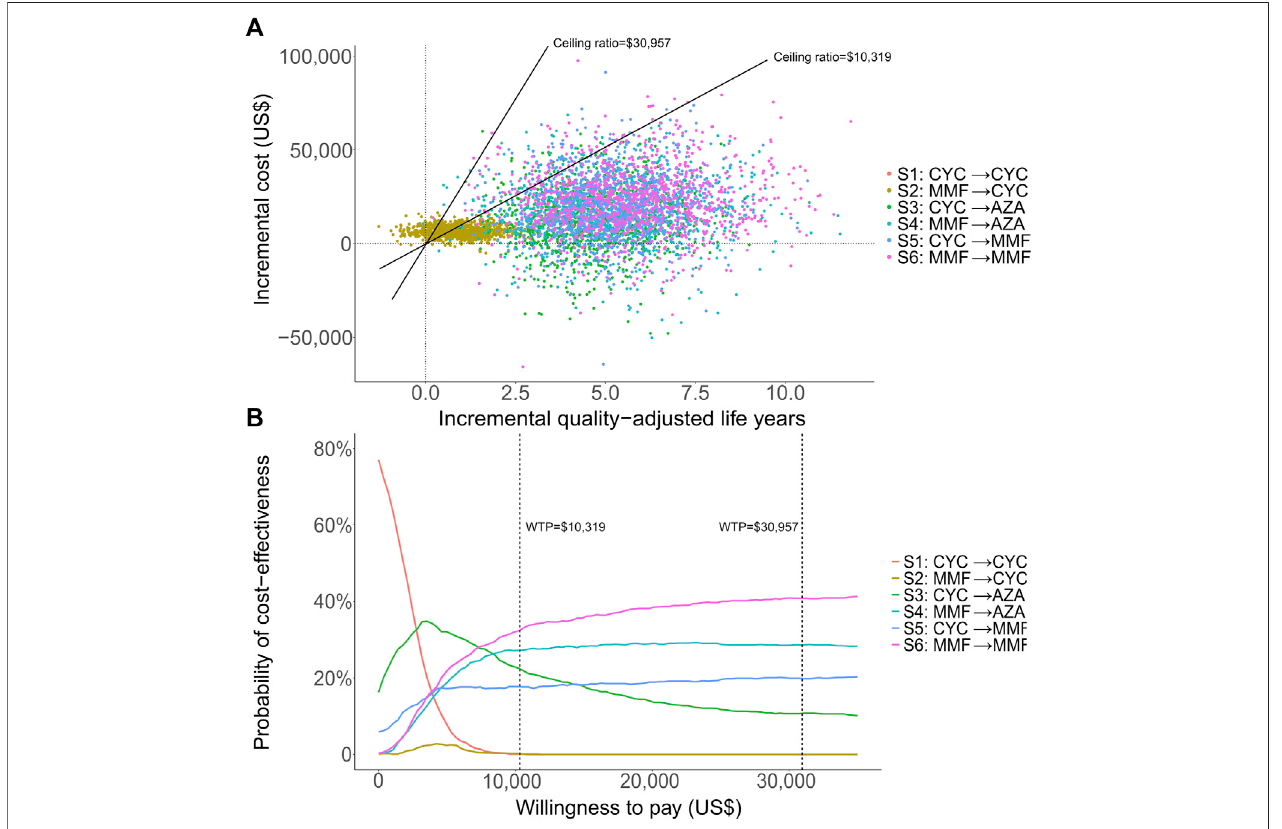
FIGURE3| Probabilisticanalyticresultsforthescenariooveralifetimehorizon:theincrementalcost-effectivenessdifferencessimulatedwith1,000patients (A) and the cost-effectiveness acceptability curves of all strategies (B) . One-time and three-time gross domestic product per capita were used for the willingness to pay thresholds, at US$10,319 and US$30,957